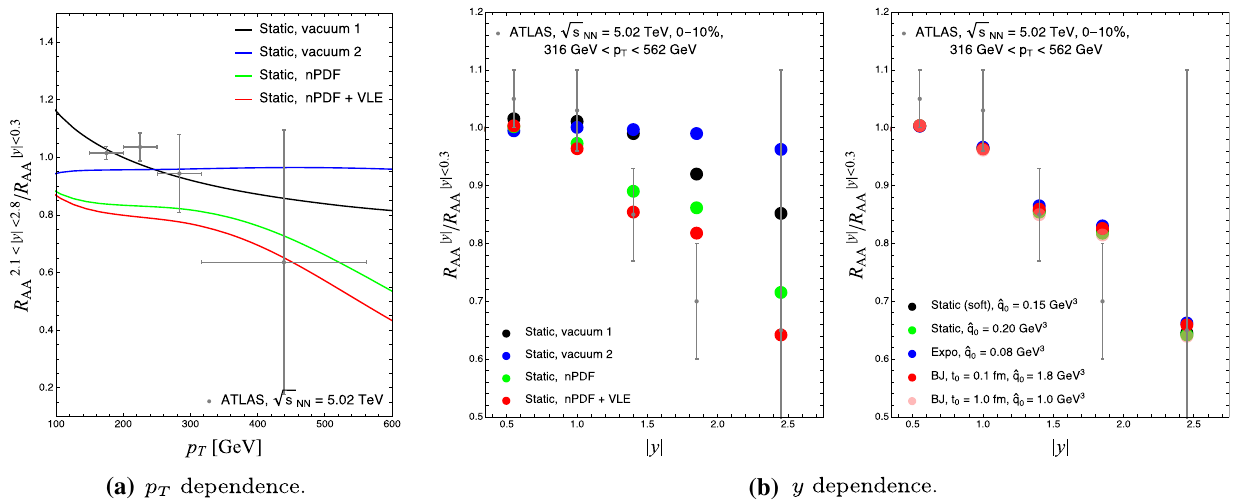
Fig. 4 Left: The ratio of R AA in 2 . 1 < | y | < 2 . 8 and R AA in | y | < 0 . 3 in the left and middle panels. Black, green, blue, red and pink color encodes static soft, static, exponential, and two Bjorken medium pro- as a function of jet p T . Middle and Right: The ratio of R AA in different | y | binsand R | y | < 0 . 3for p files, respectively, in the right panel. The ATLAS data taken from Ref. AA in T =316-512GeV.Black,blue,green, andredcolorencodesstaticmediumfor“vacuum1”,“vacuum2”,static medium with nPDF effects, and with nPDF+VLE effects, respectively,